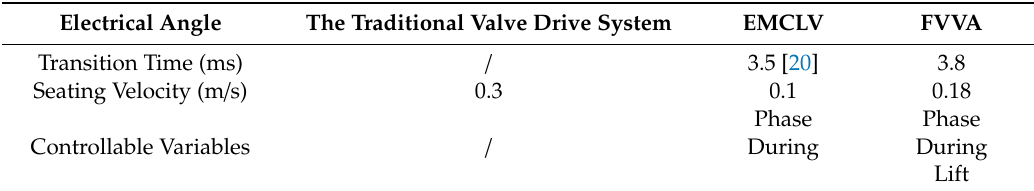
Table 4. Comparison of performance of the three